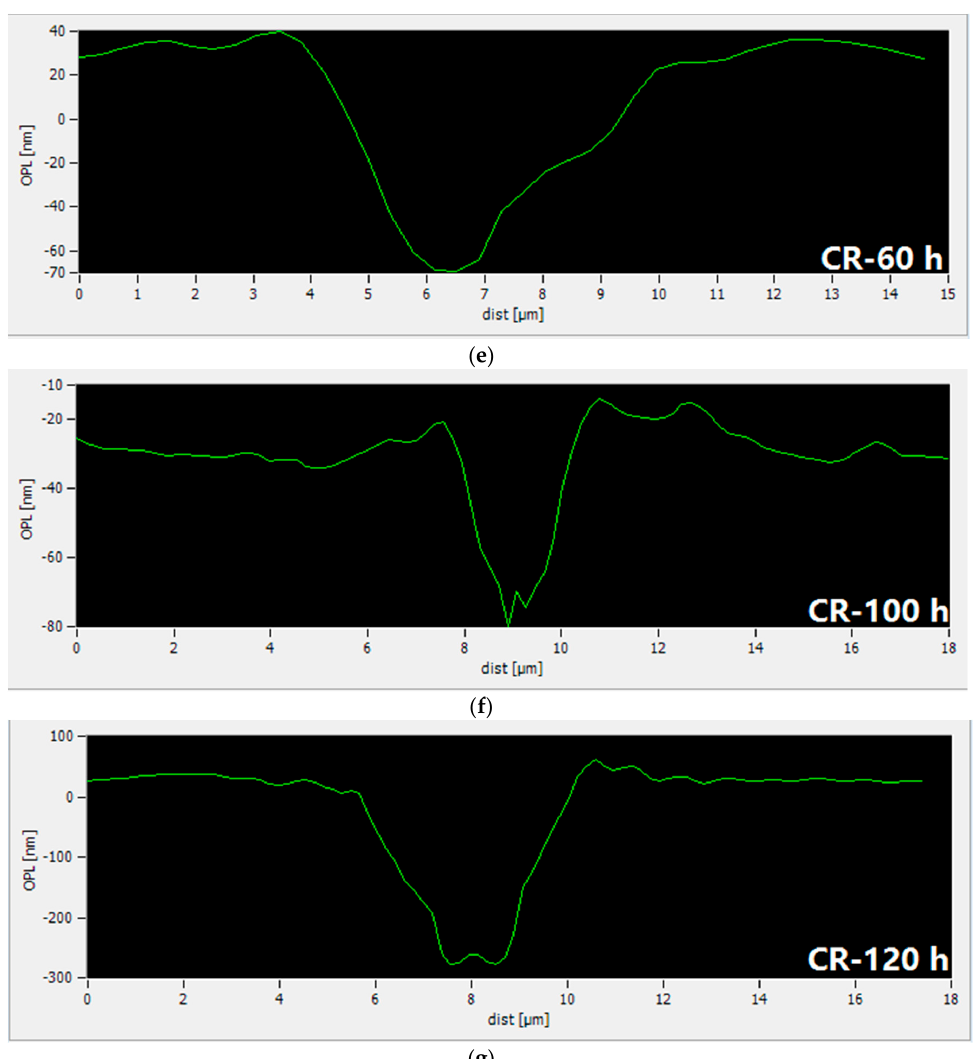
Figure 4. Surface morphology and height and depth of pits in corrosion resistant alloy steel bars at different corrosive exposure times. ( a ) Surface morphology for CR at 0 and 24 h; ( b ) Surface morphology for CR at 60 and 100 h; ( c ) Surface morphology for CR at 120 h; ( d ) Height and depth of pits for CR at 24 h; ( e ) Height and depth of pits for CR at 60 h; ( f ) Height and depth of pits for CR at 100 h; and ( g ) Height and depth of pits for CR at 120 h.